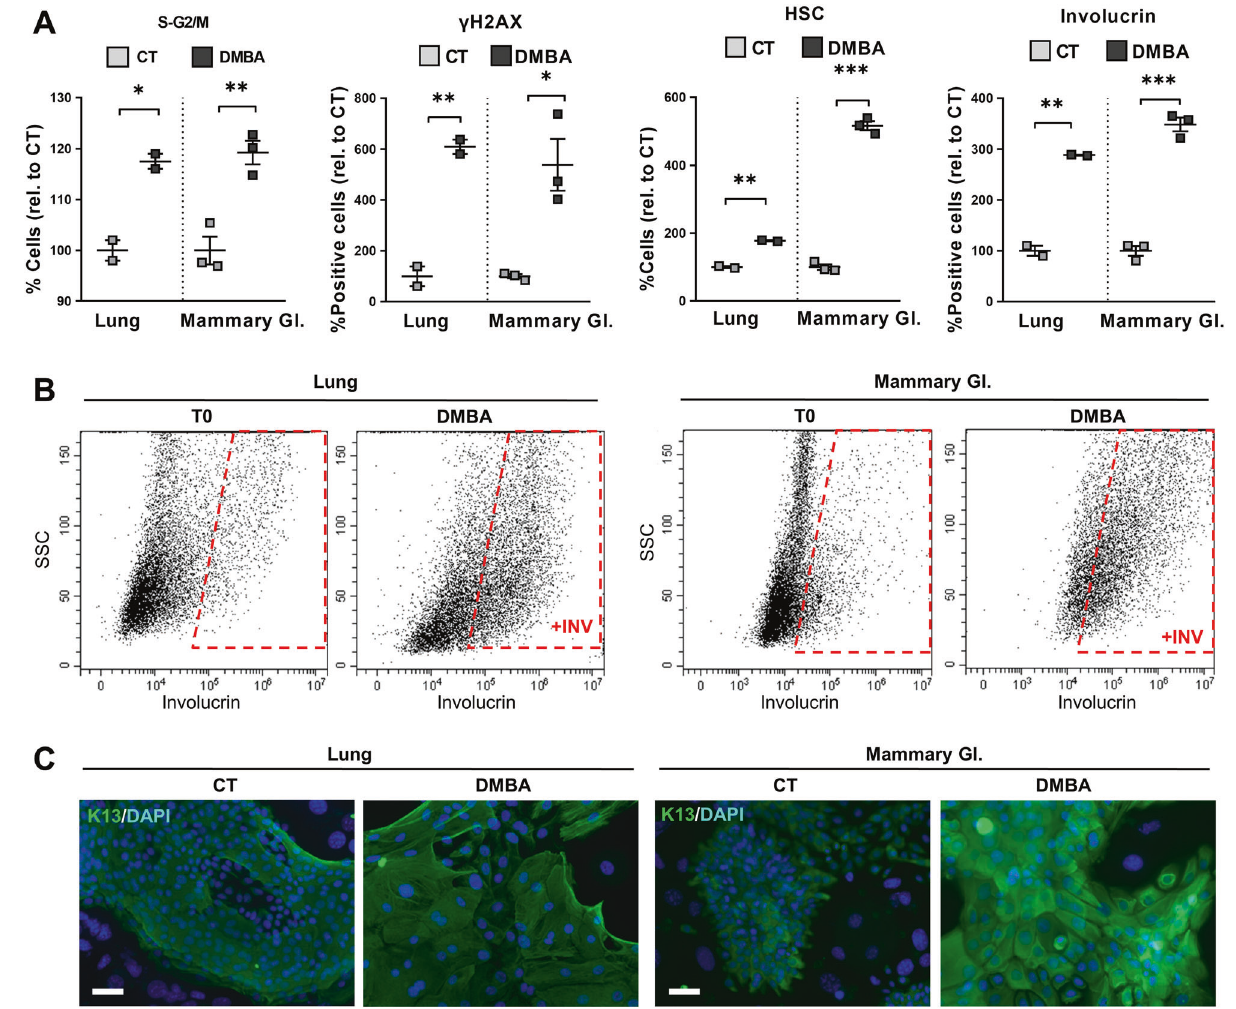
Fig. 4 Lung and mammary gland epithelial cells undergo squamous metaplasia upon tobacco carcinogen DMBA. Human primary lung or mammary gland (Mammary Gl.) epithelial cells were treated with dimethyl sulfoxide (CT) or with 1 μ g/ml DMBA for 24 h (A, S-G2/M, and yH2AX) or 72 h ( A , HSC and involucrin, B , C ). A Flow cytometry quantitations for the percent of, from left to right: cells in the S-G2/M phase of the cell cycle, γ H2AX positive cells, cells with high light scatter (HSC) typical of squamous differentiation, involucrin positive cells, all relative to CT. B Representative fl ow cytometry analyses for the differentiation marker involucrin. + INV, positive cells; T0 = untreated cells. C Representative immuno fl uorescence for keratin K13 (green) upon the indicated treatments. Blue is nuclear DNA by DAPI. Scale bar, 50 μ m. Positive cells by fl ow cytometry were gated according to negative isotype antibody control. Data are mean ± SEM of two or three replicate samples, representative of 2 – 3 independent experiment from two different human individuals with similar results. *** p ≤ 0.001, ** p ≤ 0.01, * p ≤